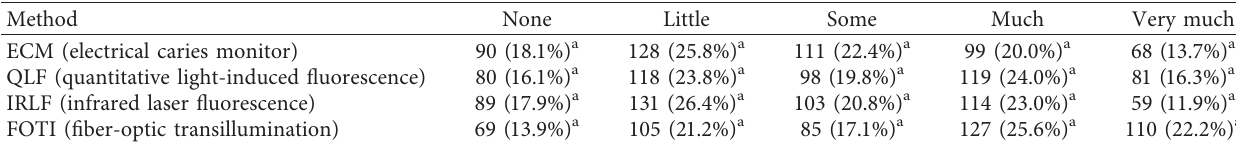
Table 4: Reported knowledge of advanced diagnostic methods.